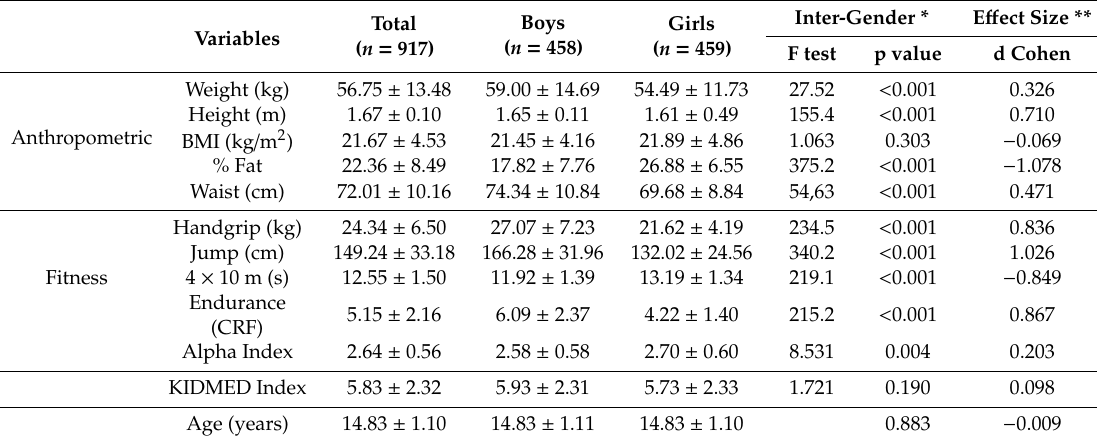
Table 1. Anthropometric characteristics, physical fitness variables (Alpha Fitness Battery) and Mediterranean Diet Adherence (KIDMED). Inter-gender comparisons (M ± SD).